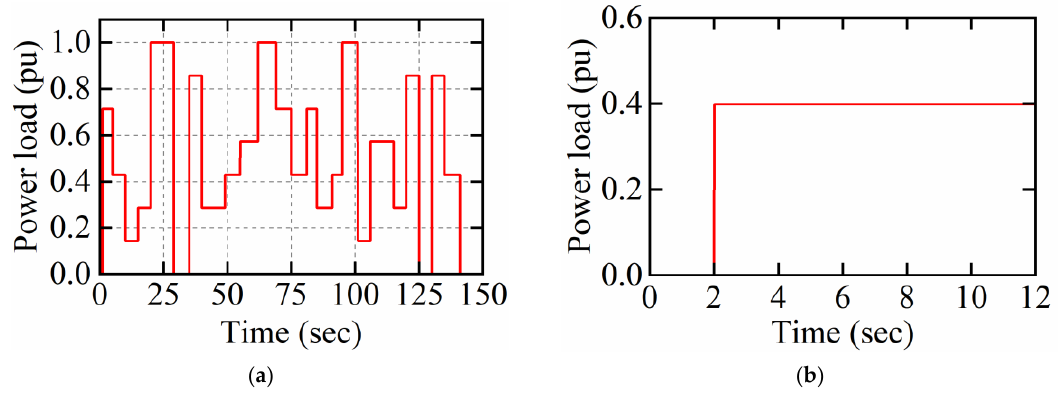
Figure 4. ( a ) Training set input signal; ( b ) testing set input signal.